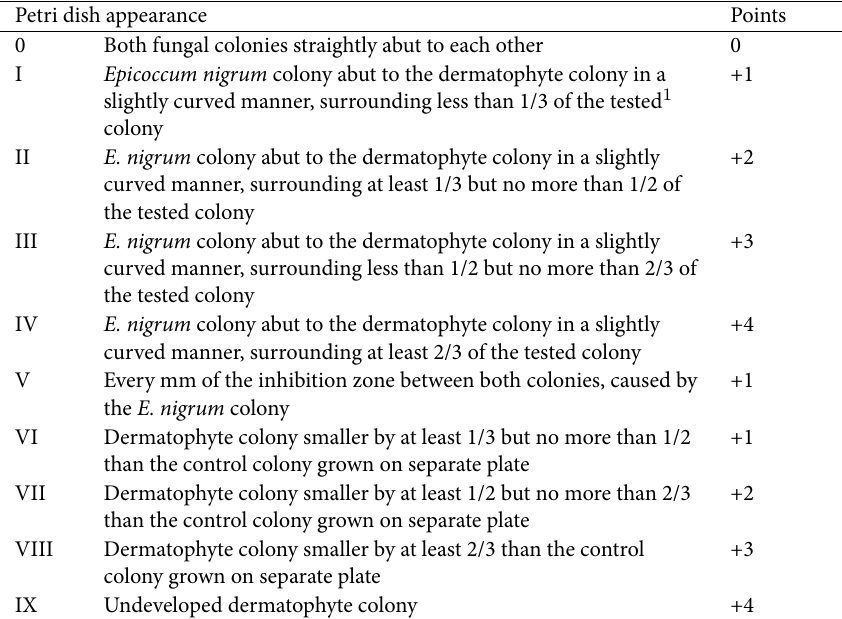
Table 1 The scale of scoring the biotic effects of the Epicoccum nigrum colony on the dermatophyte